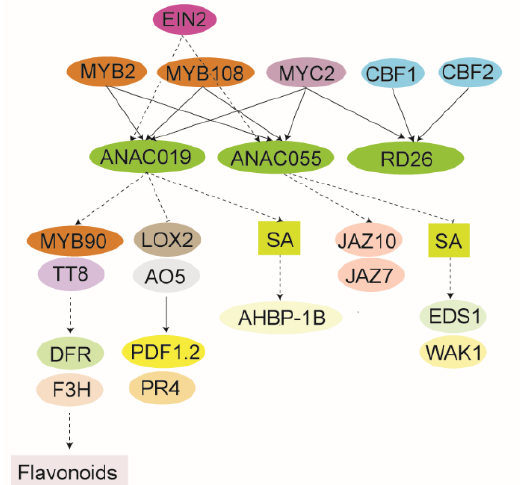
Figure 3. Schematic showing predicted local GRN of senescence-associated ANAC019, ANAC055, and RD726. All connections are derived from a study based on yeast one-hybrid screenings, time-course gene expression data, and mathematical modeling by Hickman et al. [66], except for the EIN2-ANAC019/ANAC055 and MYC2-ANAC019/ ANAC055/RC26 connections which were derived from Kim et al. [108] and Zheng et al. [104], respectively. Thus, all components may not be part of the same functional GRN. The ANAC019, ANAC055, and RD26 have similar expression patterns with induction by ABA and different abiotic stress exposures [43,79,80,89]. Direct binding is shown as black lines, whereas broken lines indicate an effect which may not necessary involve a direct interaction. NAC genes/proteins are shown in green. The rest of the color coding is specific for specific compounds or